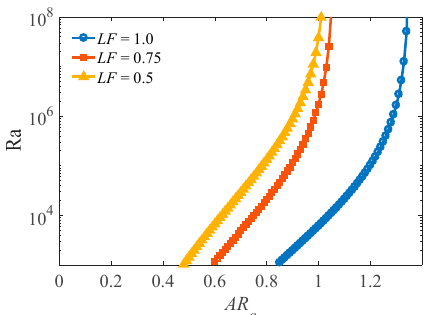
Figure 18. The neutral curves of the critical aspect ratio when the bottom heated wall and lateral heated wall need the same melting time.